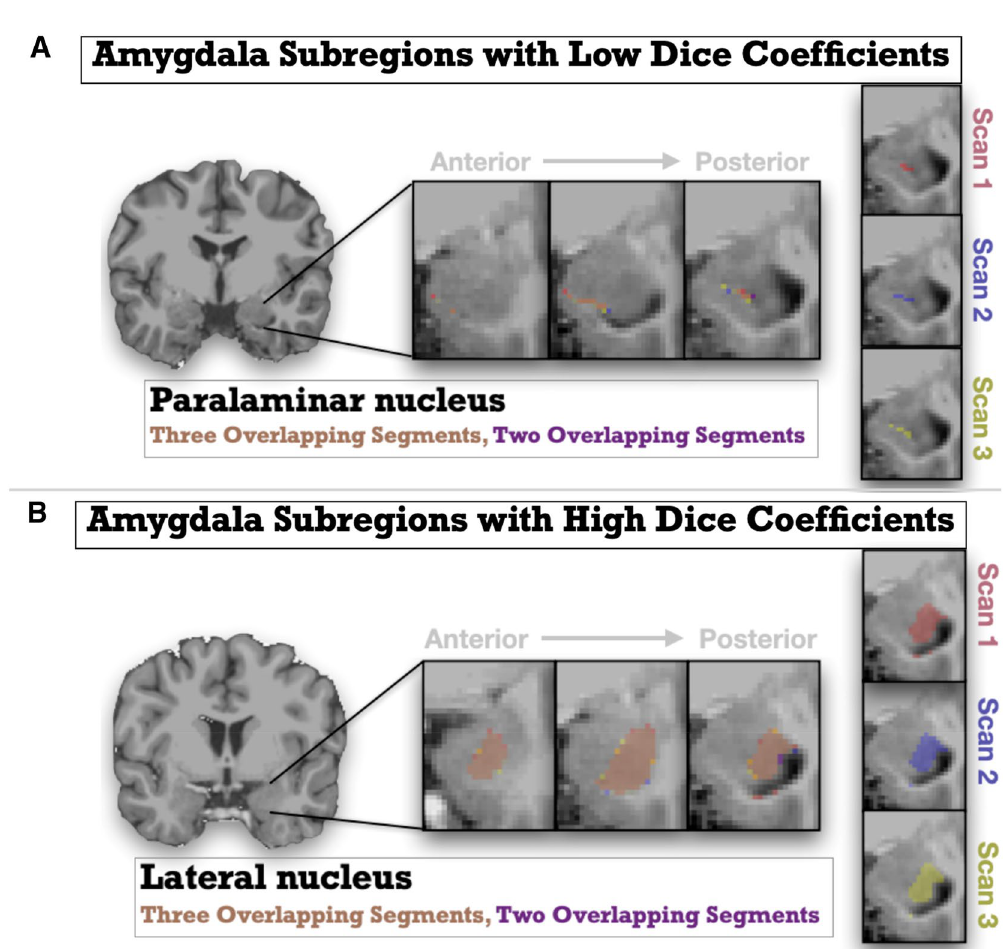
Fig. 6 Graphic representations showing magnified depictions of Amygdala subregions with low and high Dice coefficients (i.e., spatial reliability) from repeated scans (Scan 1 shown in Red; Scan 2 shown in Purple, Scan 3 shown in Yellow). The anatomical (T1w) image underlaid is the unbiased subject template from an example participant. The top panel A represents the paralaminar nucleus, an area with low spatial reliability across scans, and the bottom panel B represents the lateral nucleus, and area with high spatial reliability. Slices move right to left from medial to lateral. Multiple slices are depicted left to right, moving anterior to